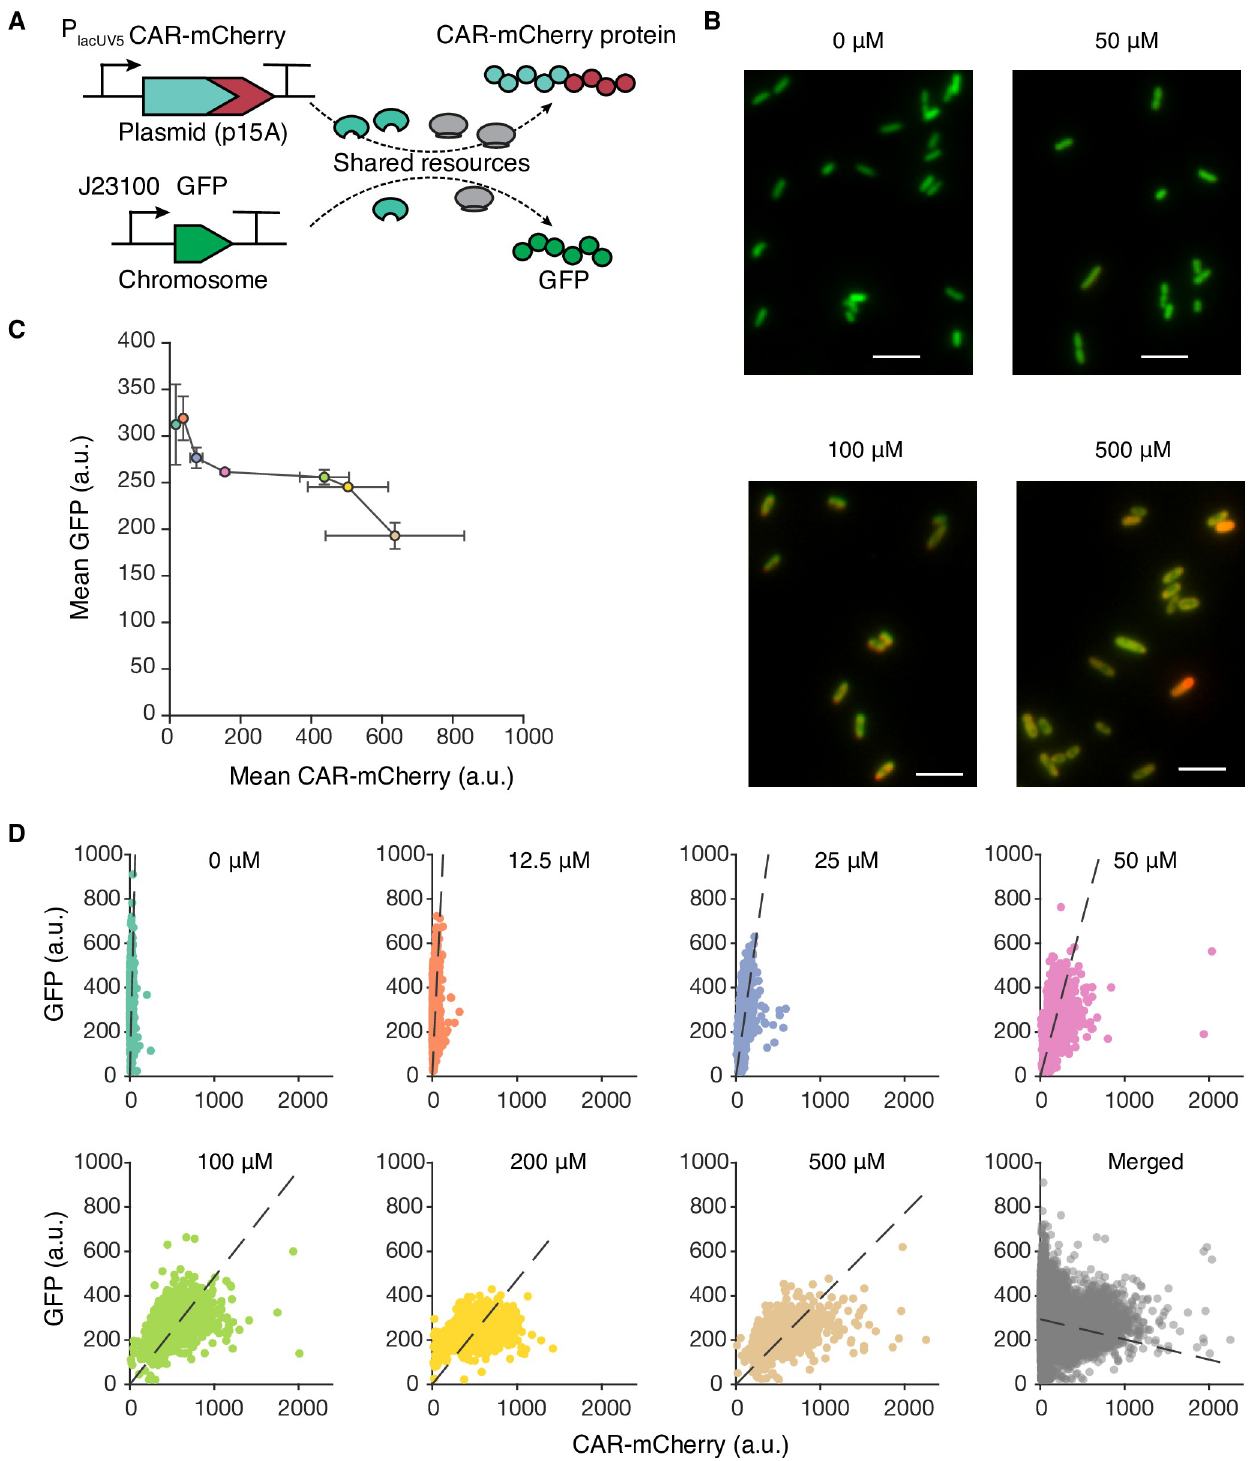
Fig 1. Multi-gene expression in single-cells during translational competition. (A) Translational competition of CAR-mCherry and GFP over limited shared ribosomes in single cells. The CAR-mCherry mRNAs are transcribed from an IPTG-inducible P lacUV5 promoter, while GFP mRNAs are constitutively transcribed. (B) Representative fluorescence images of combined green (GFP) and red (CAR-mCherry) channels at various induction levels. IPTG concentrations are labelled at the top of each image. Scale bars, 5 μ m. (C) Population mean fluorescent intensity of GFP and CAR-mCherry at various IPTG induction levels. Error bars represent standard deviations of three replicates from different days. (D) Correlation between CAR-mCherry and GFP